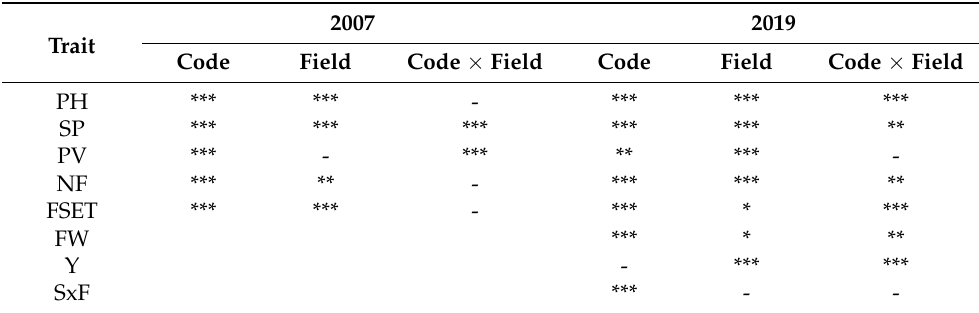
Table 3. Two-way factorial analysis of variance for plant height (PH), stigma position (SP), pollen viability (PV), number of flowers per inflorescence (NF), and fruit set (FSET) in 2007 and 2019, and for fruit weight (FW), yield (Y), and number of seeds per fruit (SxF) in 2019. *, **, and *** indicate significance of the main factors, Code and Field, and of their interaction for p ≤ 0.05, 0.01, and 0.001